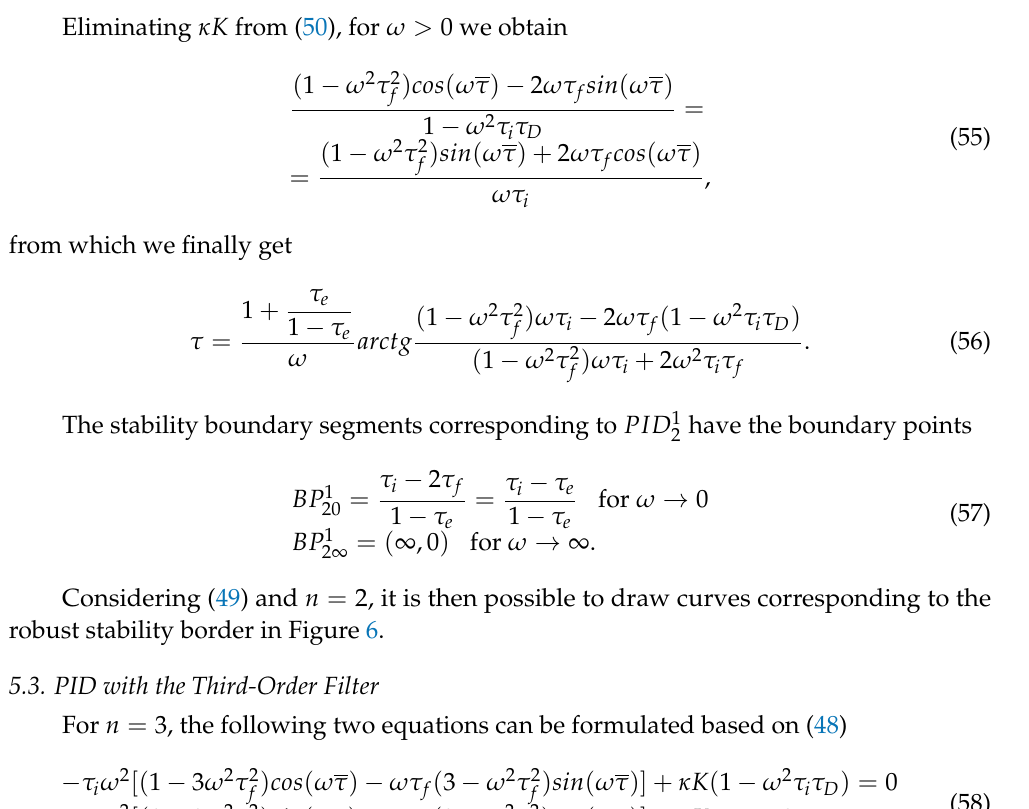
Figure 6. Stability borders of the nonfiltered PI ( PID 0 for several values of τ e = T e / ( T dp + T e ) , T dp = 1 and the average-residence-time tuning equivalence T f = T e / n , n = 1,2,3; + denoting the nominal